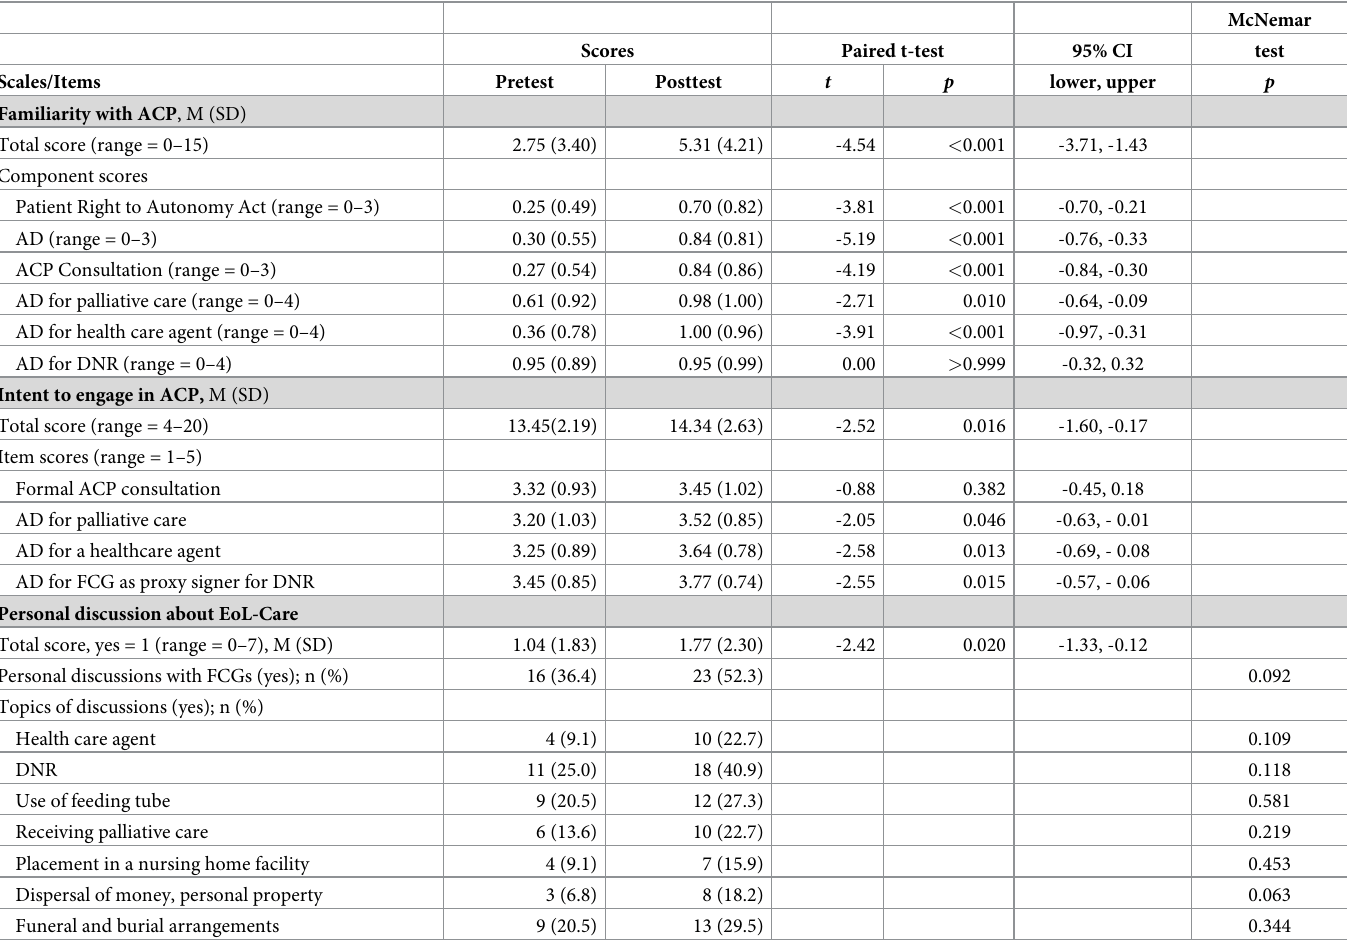
Table 3. Scale scores for PWCIs (n = 44): Familiarity with ACP, intent to engage in ACP, and participation in personal discussions about EoL-care and ACP pre- intervention (pretest) and post-intervention